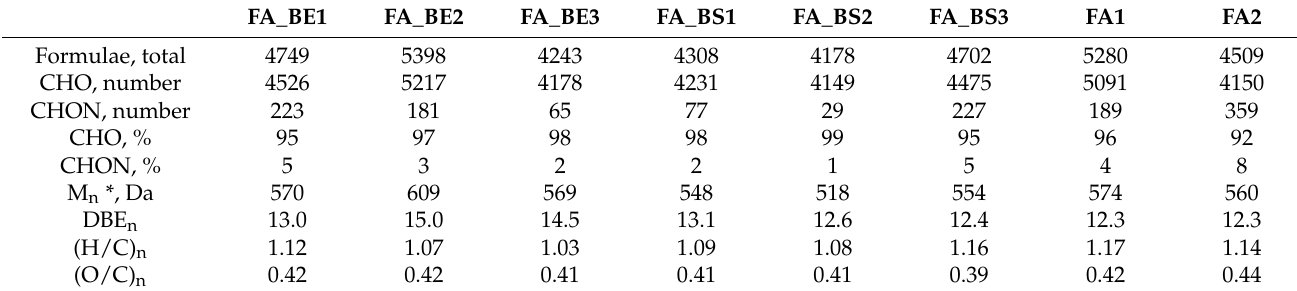
Table 1. An overview of the FT ICR MS data obtained for the FA isolates in this